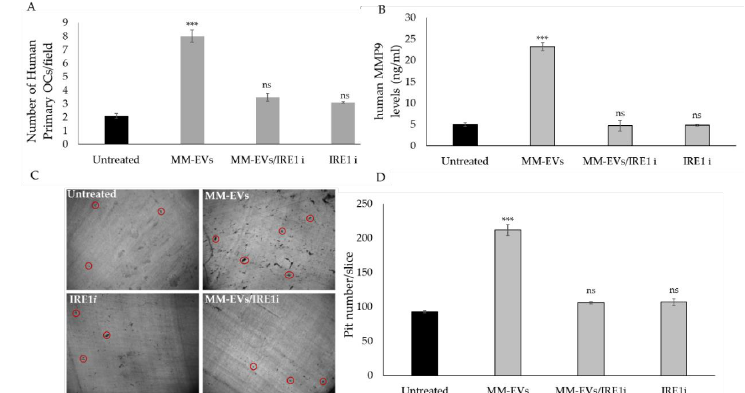
Figure 6. ( A ). Trap staining assay in human primary OCs untreated or treated for 14 days with 25 µ g / mL of MM-EVs, with 200 nM GSK2850163 (IRE1 ι ) and co-treated with MM-EVs and IRE1 ι . ( B ). ELISA assay of human MMP9 protein levels in conditioned medium of human primary OCs treated for 14 days with 25 µ g / mL of MM-EVs, with 200 nM GSK2850163 (IRE1 ι ) and co-treated with MM-EVs and IRE1 ι . The statistical significance of the di ff erences was analyzed using a Dunnett’s test (treated Groups vs. Untreated Group). ( C ). Bone resorption pit assay of human primary OCs seeded on dentine discs untreated or treated for 14 days with 25 µ g / mL of MM-EVs alone or in co-treatment with IRE1i. Representative pictures of lacunae (dark areas) formed by cells (original magnification 10 × ) are reported. Some red circles are added to indicate some resorption pits. ( D ). Data relative to the pits number formed by the erosive action of mature OCs, after 14 days of treatment with 25 µ g / mL of MM-EVs or co-treated with MM-EVs and IRE1 ι , are represented. Three fields of each dentin disc for each experimental point were scored in three independent experiments. The number of the pits was calculated by NIH image J software analysis (http: / rsbweb.nih.gov / ij / ). The statistical significance of the di ff erences was analyzed using a Dunnett’s test (treated Groups vs. Untreated Group) (*** p -value < 0.0005, ns not